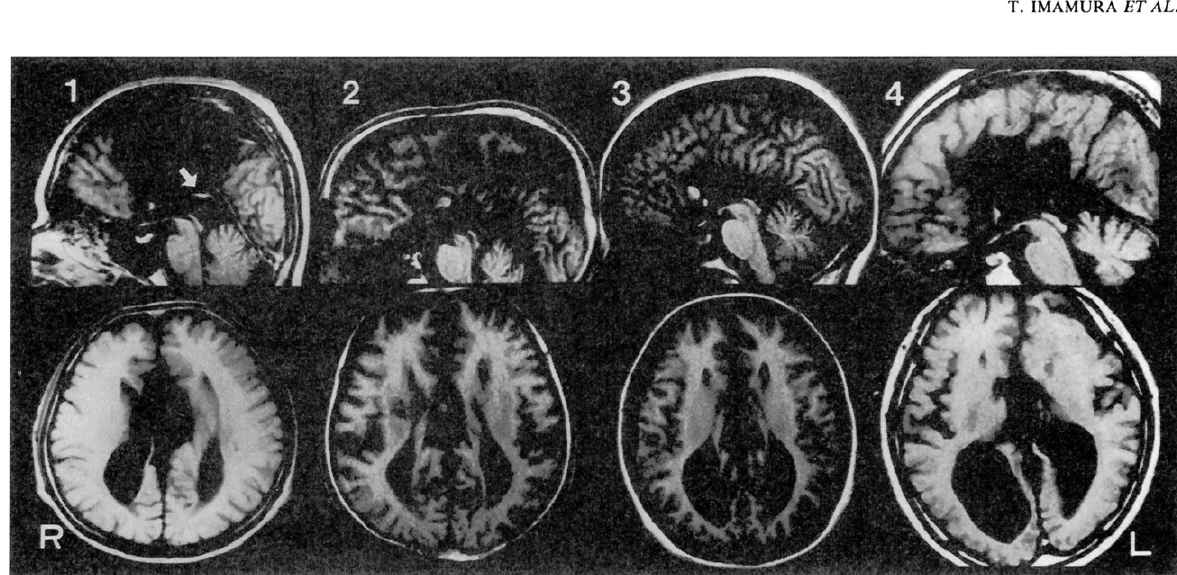
FIG. 1. Sagittal (top) and axial (bottom) MRI revealed callosal agenesis and associated anomalies of patients. Arabic numerals indicate patient numbers. In sagittal image of Patient 1, the wall of the subarachnoid cyst resembles corpus callosum